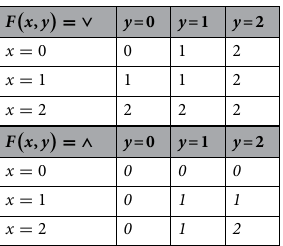
Table 2. Values of the logical function corresponding to the operations of disjunction and conjunction in the logic of paradoxes by G. Priest.